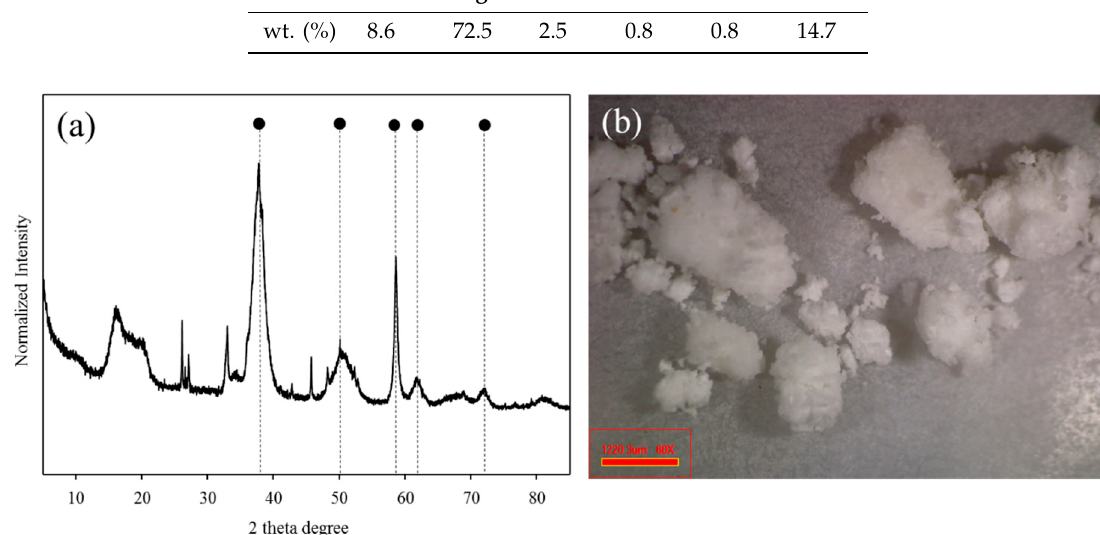
Figure 1. The X-ray diffraction pattern ( a ) and the microscopic image ( b ) of the brucite (magnesium hydroxide)-rich precipitate (BP).